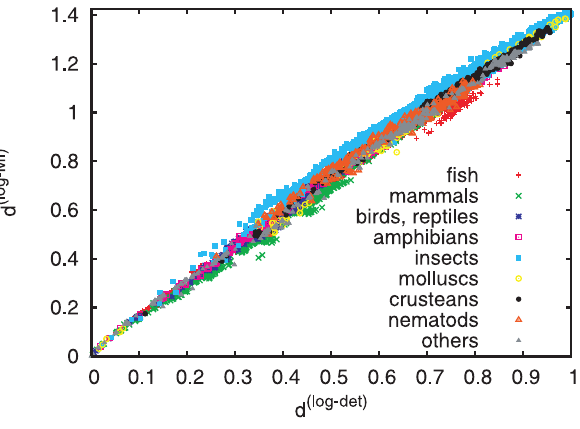
Figure 6. Scatter plot comparing d ( log { MI ) letter Shannon entropies) to d ( log { det ) chosen pairs of